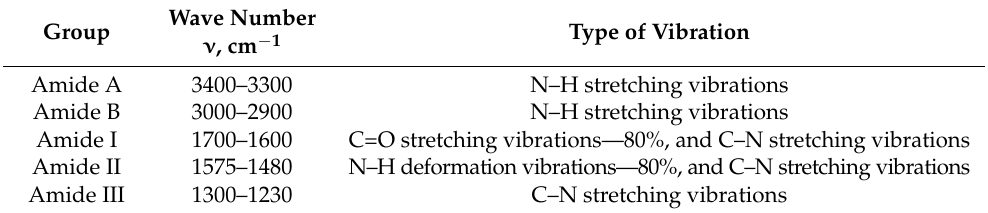
Table 5. Main adsorption bands of the functional groups of gelatin [36,37].